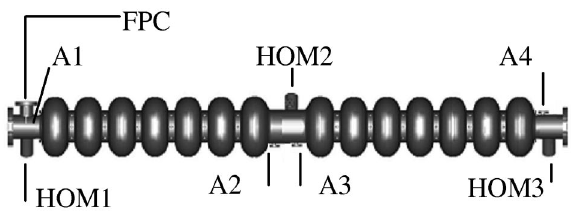
FIG. 5. Prototype of 2 (cid:2) 7 cells. Field probes: A1–A4. HOM couplers: HOM1–HOM3.